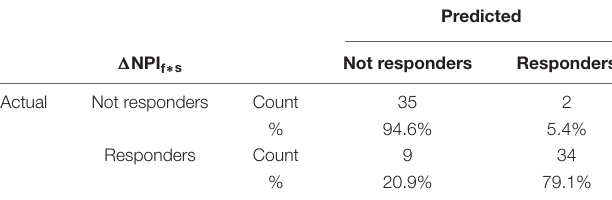
TABLE 7 | Random Forest